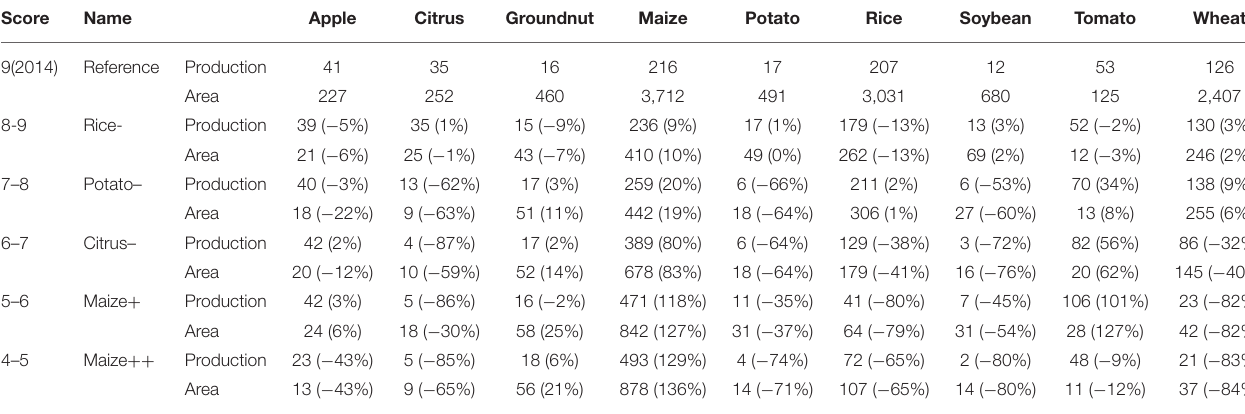
TABLE 1 | Crop production allocations selected from scored segments.